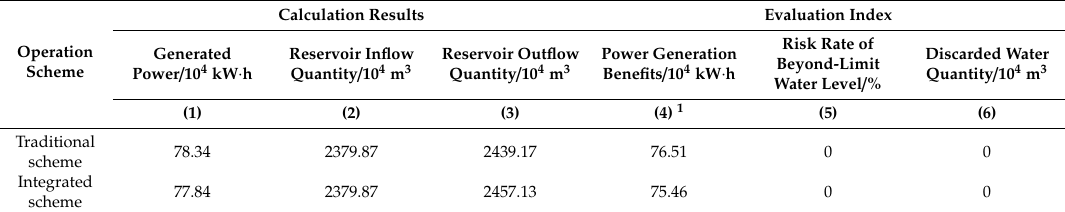
Table 2. Calculation results of the 1st operating condition.